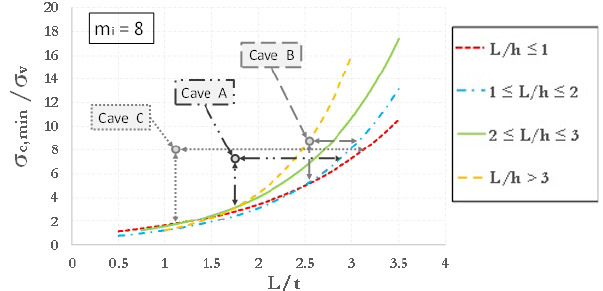
Figure 23. Application of the stability chart ( m i = 8) to the three underground quarries at